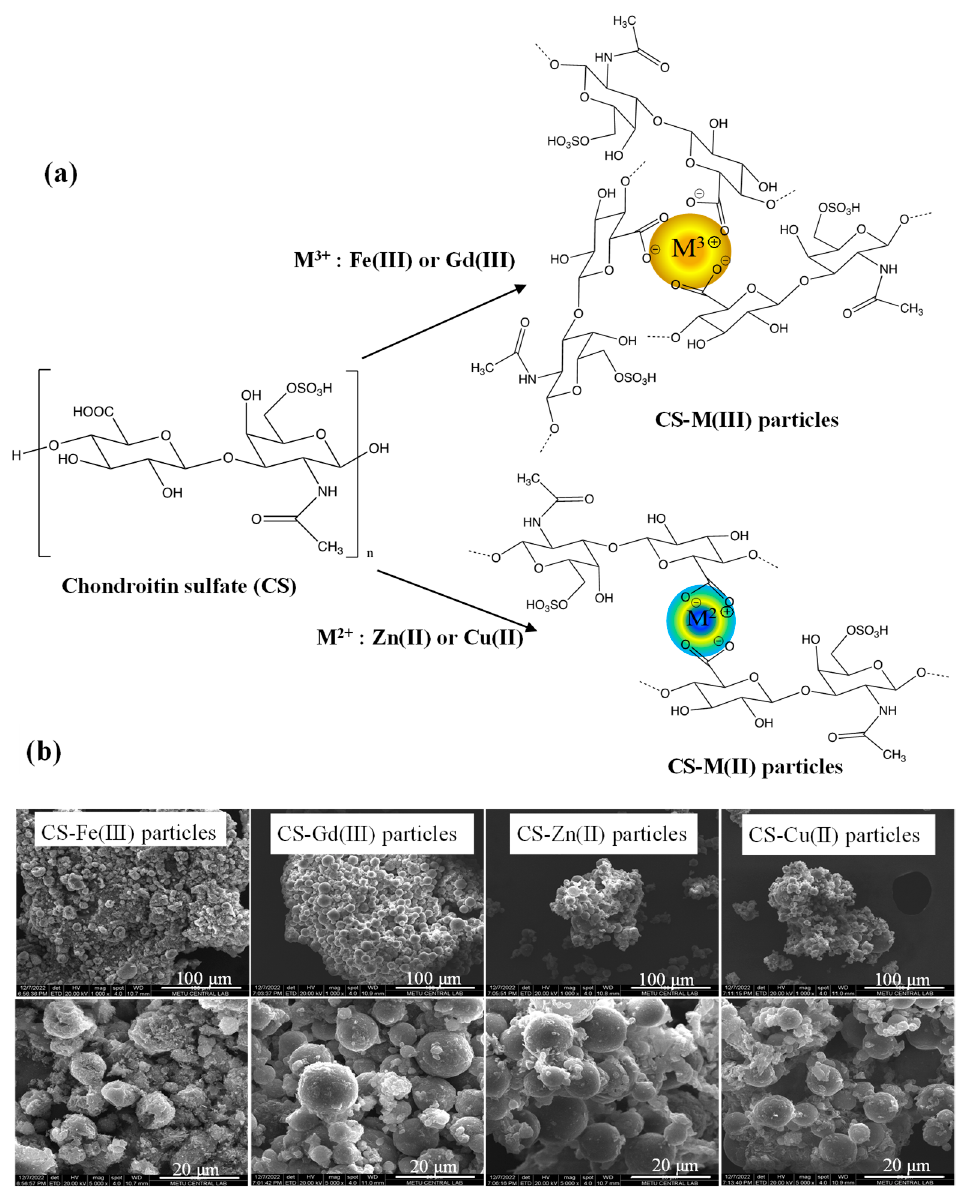
Figure 1. ( a ) Schematic representation of synthesis reaction of CS-M(III) and CS-M(II) particles and ( b ) their SEM images.